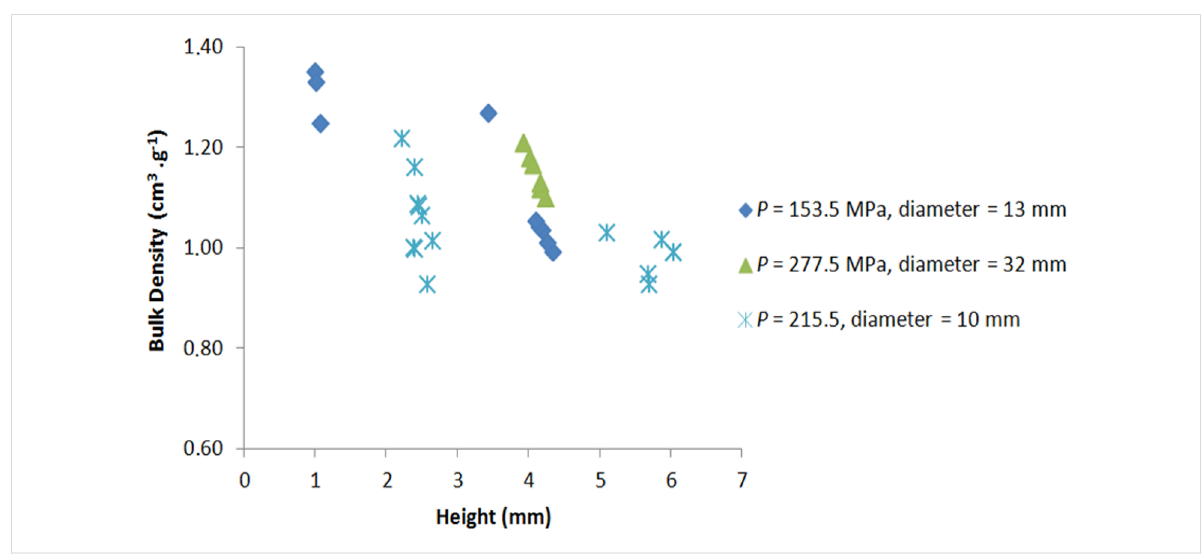
Figure 4: Bulk pellet density as a function of pellet height for different applied pressures. The diameters of the studied pellets are 10, 13 and 32 mm for applied pressures of 215.5, 153.5 and 277.5 MPa, respectively.